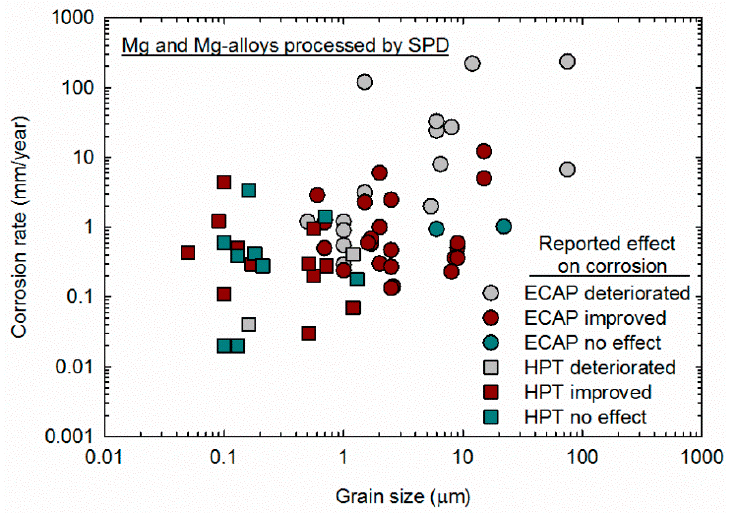
Figure 10. Corrosion rate reported in samples of magnesium processed via ECAP [52,55–59,61– 67,69,71,73–80,82–87] and HPT [19,88,90–95,97–100] plo tt ed as a function of the grain